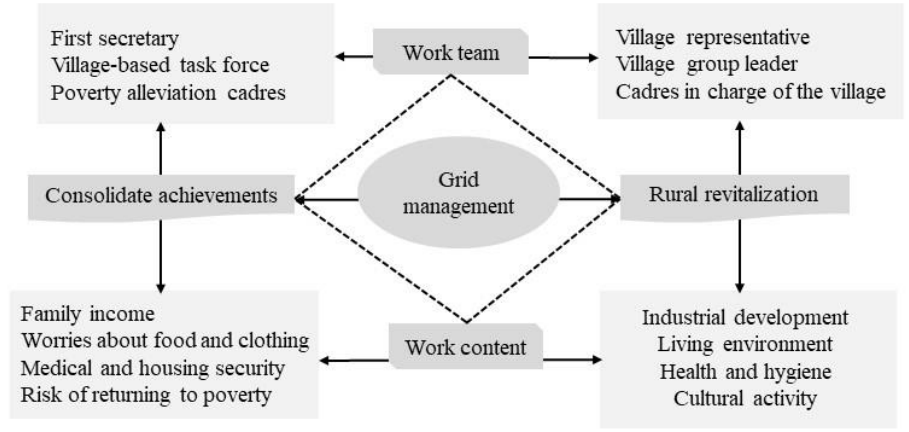
Figure 7. Grid management and organizational revitalization in Wanjigou village.